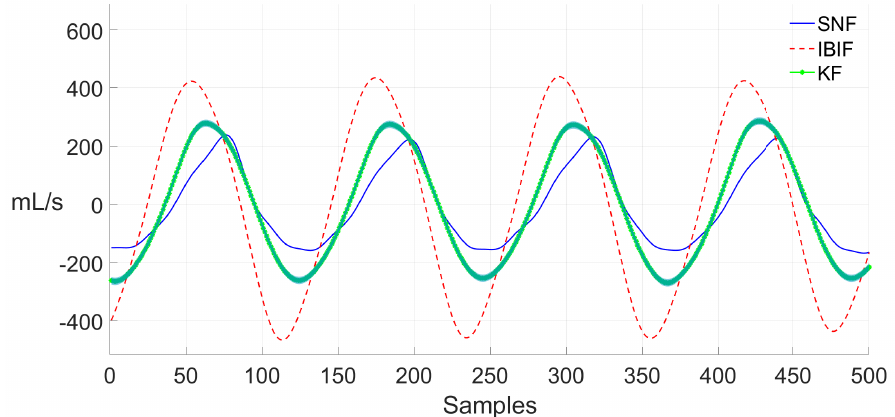
Figure 12. Section from the Rainbow passage (female PVH) with estimations of GVV: Kalman filter (solid and dot green), IBIF (dashed red), and single notch filter (solid blue). The estimation of GVV using Kalman filter includes ± 2 σ (standard deviation) on the green shaded